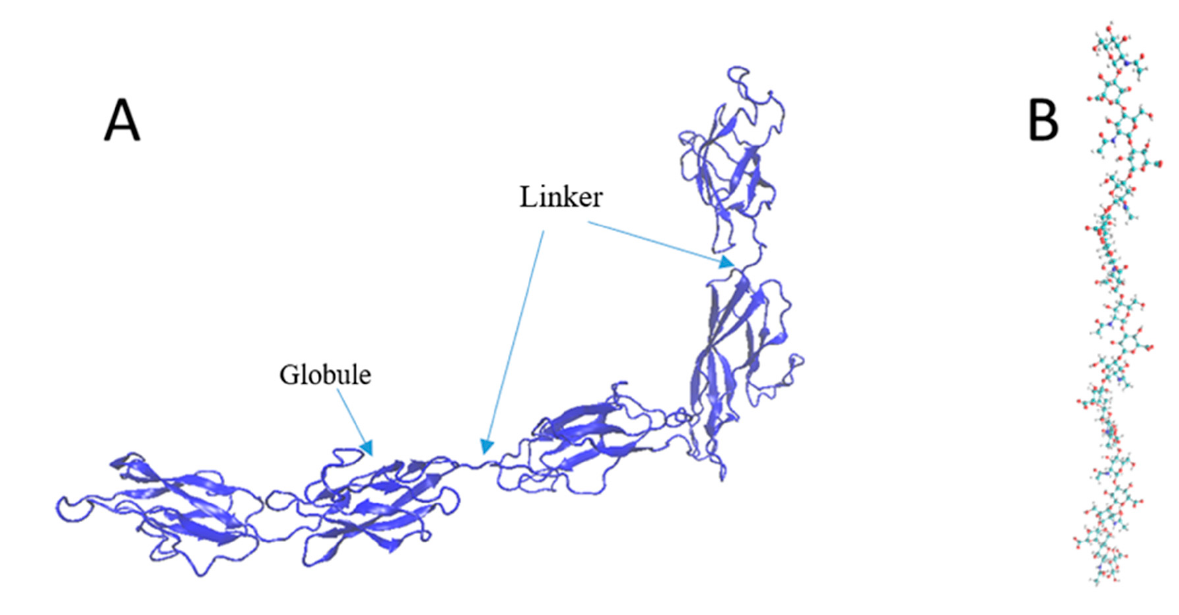
Figure 3. Structure of ( A ) the CP (new cartoon representation) and ( B ) HA (all-atom representation).